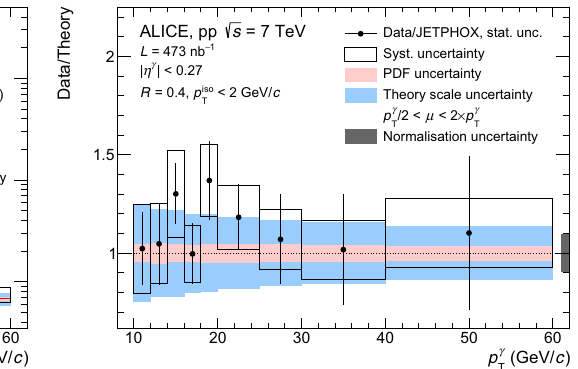
Fig. 8 Isolated photon differential cross section measured in pp col- √ s = 7 TeV (left plot). Error bars are statistical and boxes lisions at systematic uncertainties. The bands correspond to pQCD calculations